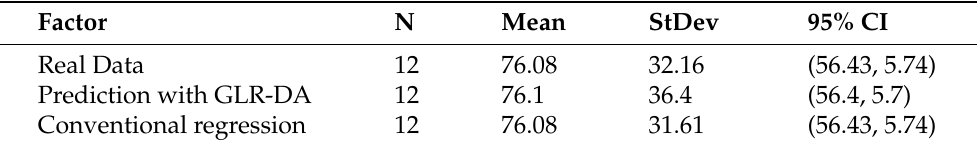
Table 8. Confidence Interval